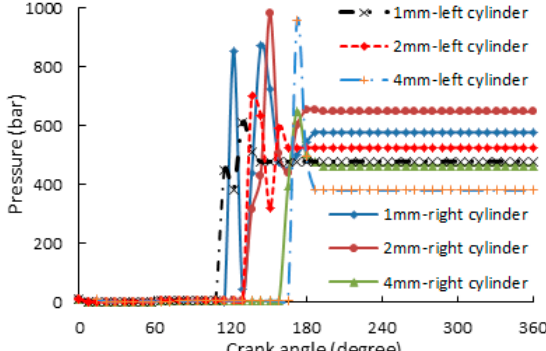
/ min with di ff erent adjustment